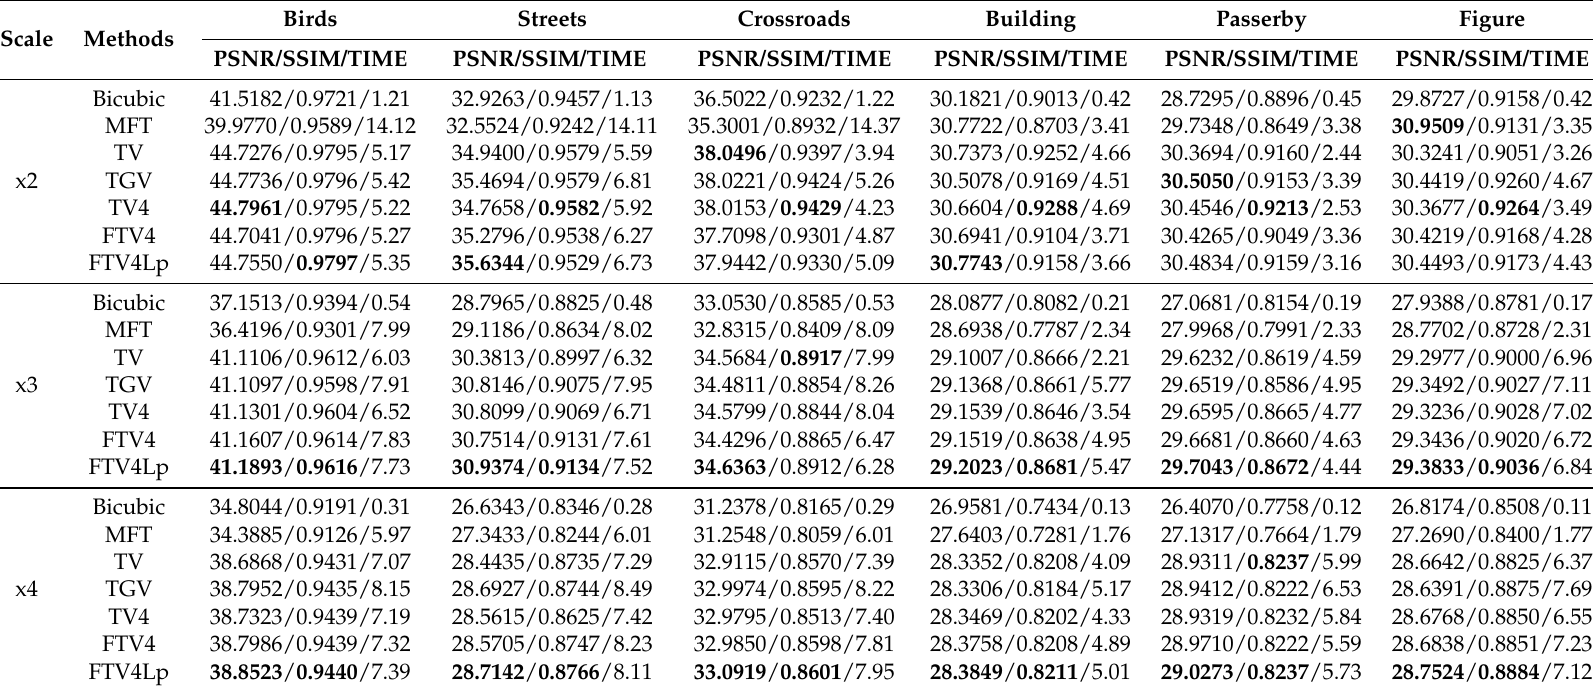
Table 1. Infrared image super-resolution experiment without